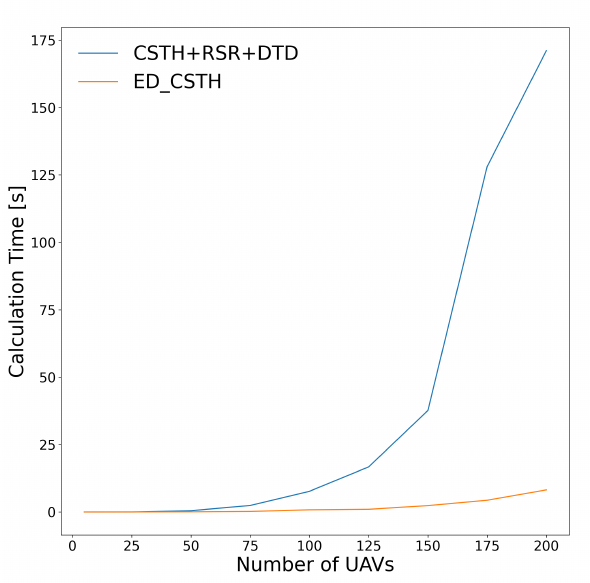
Figure 19. Calculation time in linear formation.